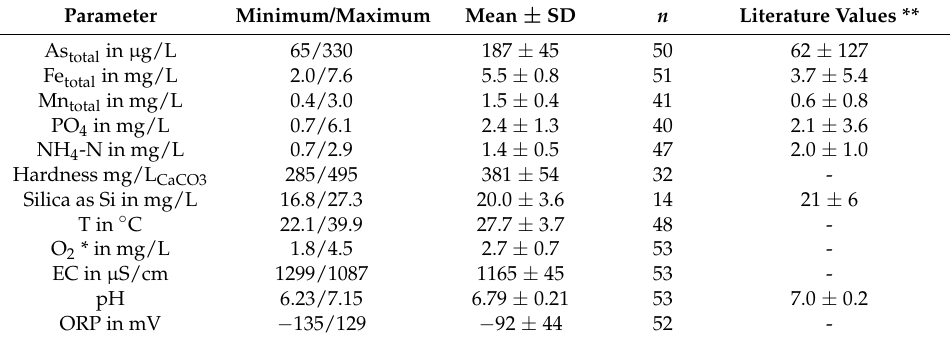
Table 4. Groundwater quality from test well during test period in West Bengal 2016–2017 and reference values from the